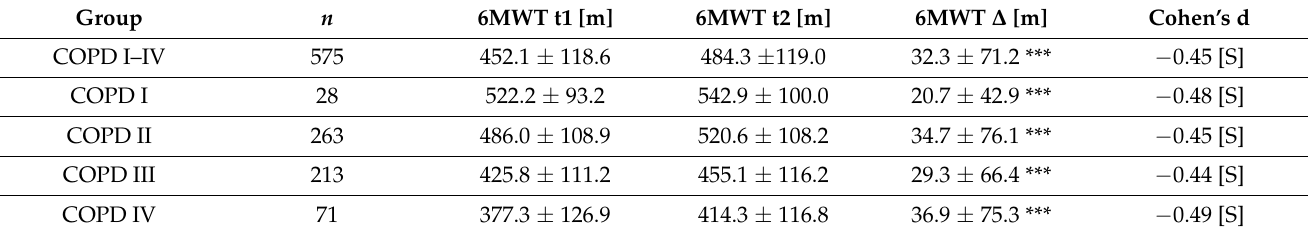
Table 2. The effect of pulmonary rehabilitation on the six-minute walking test